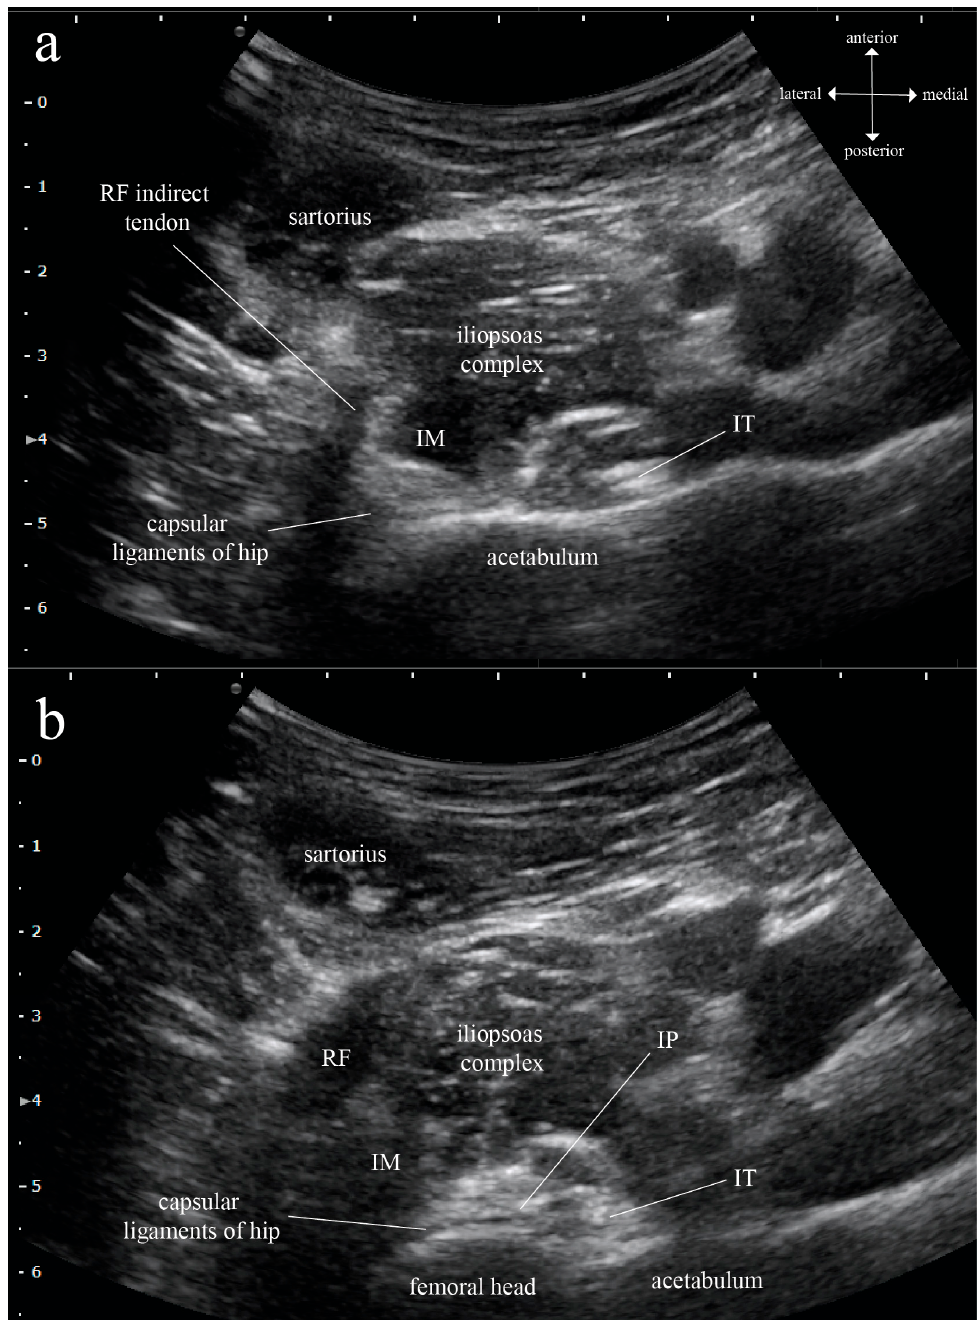
Figure 2. Ultrasound transverse scan of the human right hip with a curvilinear probe: ( a ) At the level corresponding to Figure 1a, the rectus femoris (RF) indirect tendon is an easily identifiable, elongated hypoechoic shadow lateral to the iliopsoas complex that can be used as a startup sonographic landmark to identify the iliopsoas plane (IP) at the level of iliopsoas plane block (IPB) and anterior hip pericapsular neurolysis. Under ultrasound, the iliopsoas complex and the capsular ligaments of hip are both hypoechoic, while iliopsoas tendon (IT) is a hyperechoic ovoid structure situated at the medial corner of iliopsoas complex. ( b ) At the level corresponding to Figure 1b, in between the iliopsoas complex and capsular ligaments of hip, the IP appears as a fuzzy, hyperechoic layer. The IM medial border is, in general, very difficult to identify sonographically, making the lateral margin of IP obscure and hard to define on ultrasound.